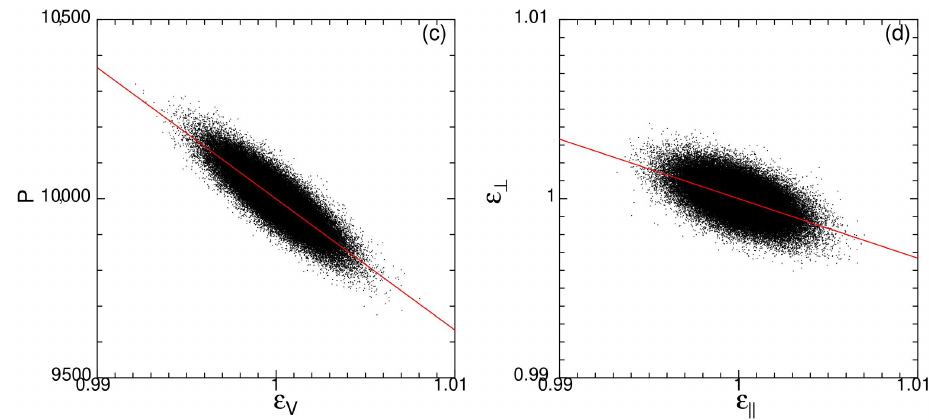
Figure A1. Spontaneous stress and strain of state G for time duration ∆ t = 1000 at temperature T = 132: ( a ) longitudinal stress versus strain, ( b ) transverse stress versus strain, ( c ) bulk stress versus strain, and ( d ) ratio between transverse and longitudinal strains, for system size N = 5376. Red lines are the linear fit to all